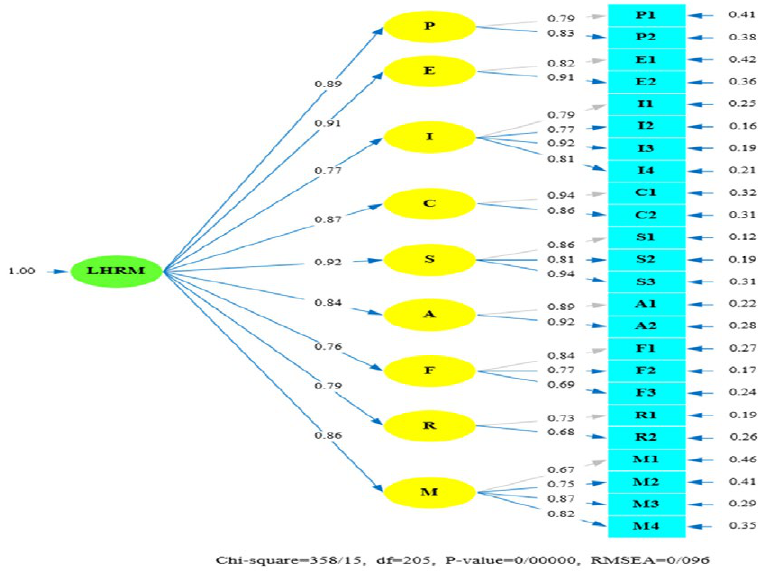
Fig. 3: The standard estimation model of “LHRM in the Islamic City Council of Tehran”